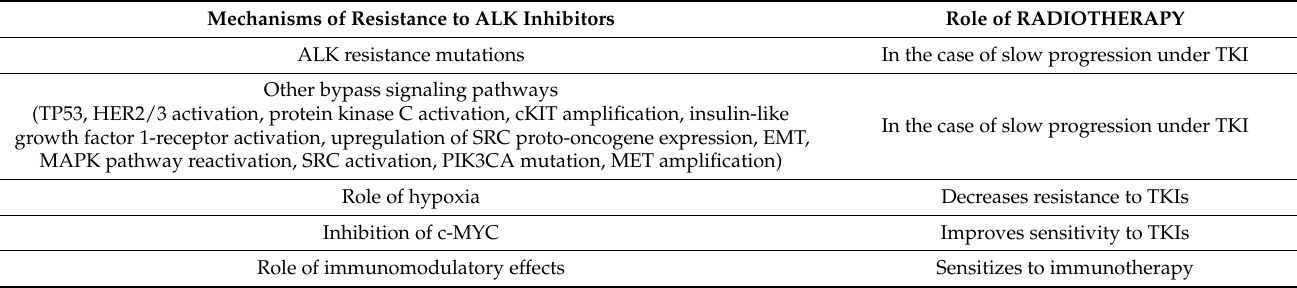
Table 3. Different mechanisms of resistance to ALK inhibitors and the role of radiation therapy. ALK: anaplastic lymphoma kinase, TKI: tyrosine kinase inhibitor.